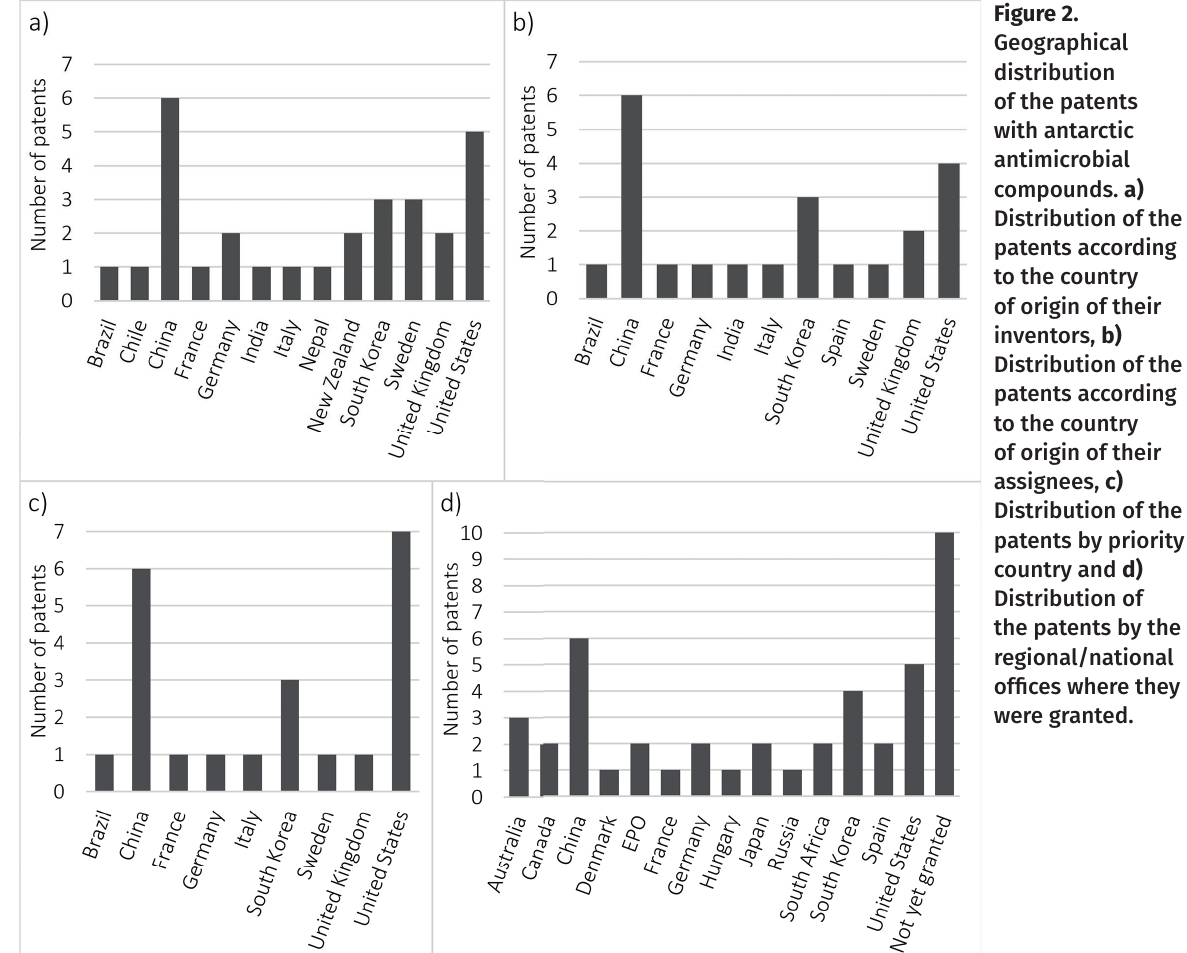
Figure 2. Geographical distribution of the patents antimicrobial compounds.